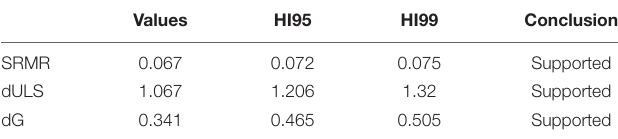
TABLE 5 | Estimated goodness of model